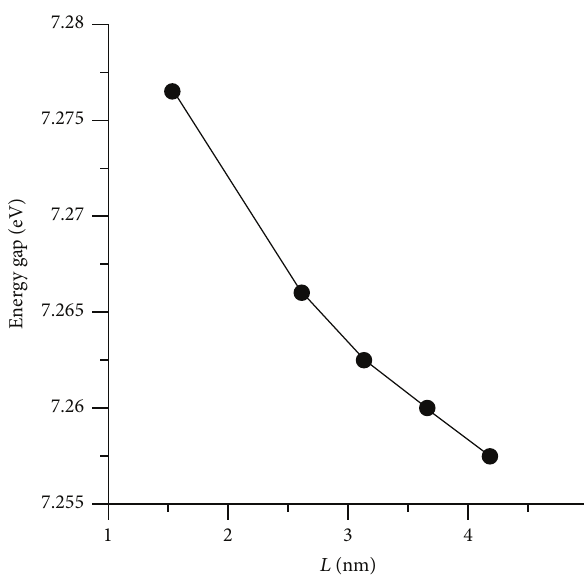
Figure 5: Dependence of the energy gap on the graphane nanoflake